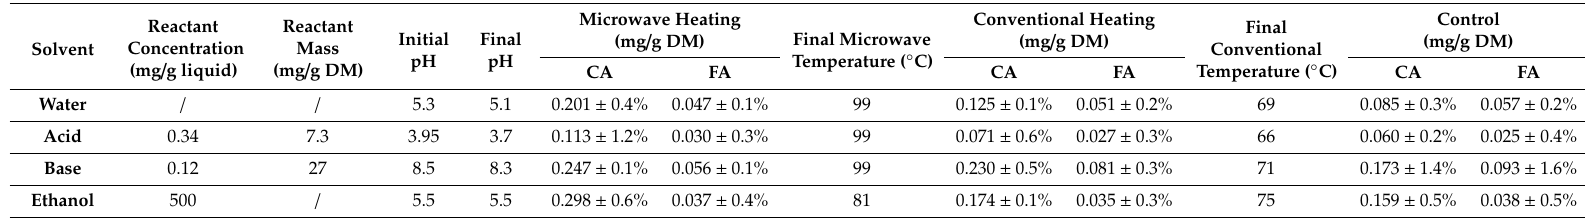
Table 2. Impact of solvents and treatments on FA and CA release in liquid phase after treatments (mg / g DM) with 200 / 10 ( w / w ) as liquid / solid ratio. Each treatment was performed in duplicate, CA and FA measurements were duplicate for each test, and the standard deviation was expressed as a